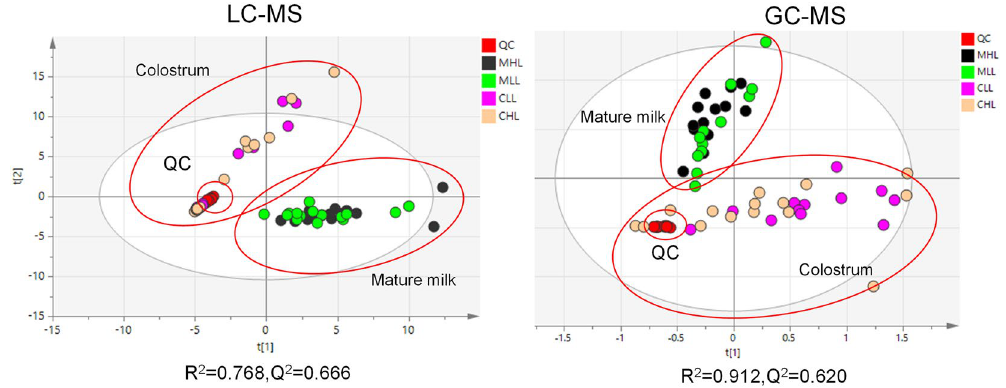
Figure 1. Score plot of PCA model built on data obtained from colostrum and mature milk by using LC-MS ( A ) or GC-MS ( B ) platforms. QC: quality control samples; MHL: mature milk samples in HL group; MLL: mature milk samples in LL group; CHL: colostrum samples in HL group; CLL: colostrum samples in LL